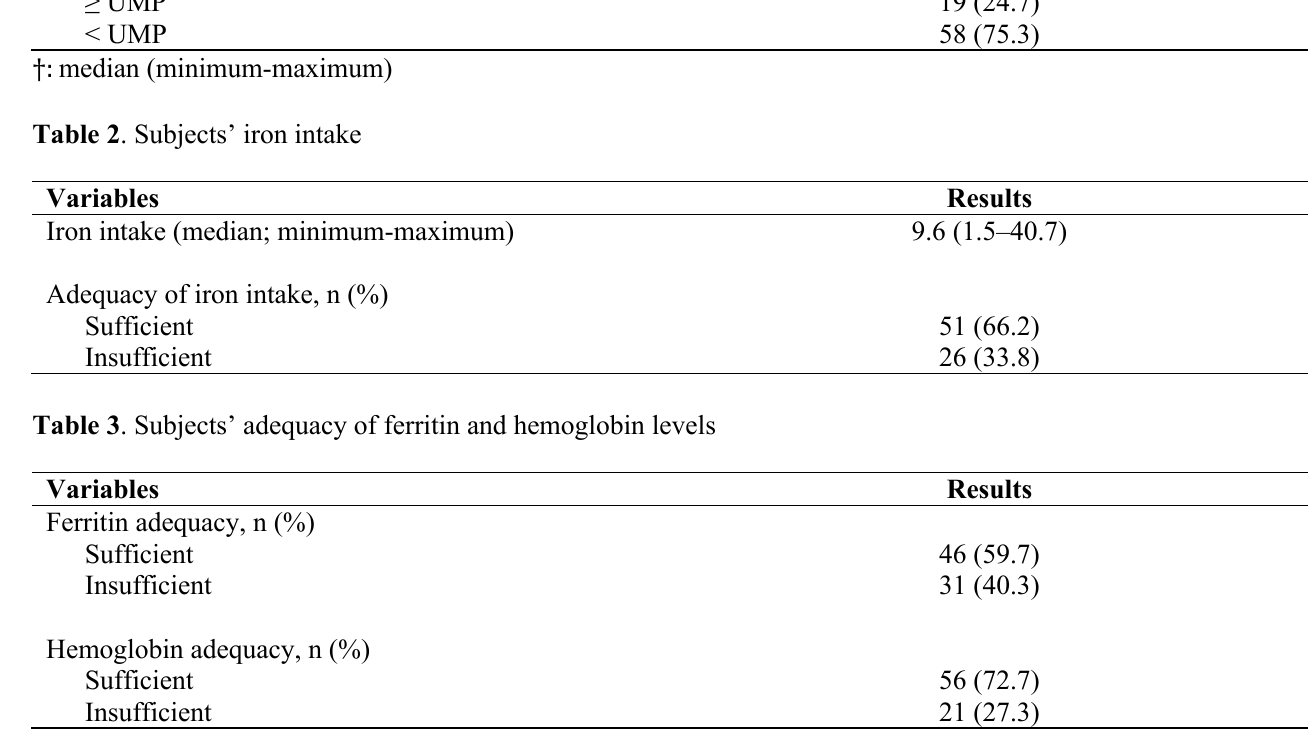
Table 4 . Correlation of iron intake with ferritin and hemoglobin